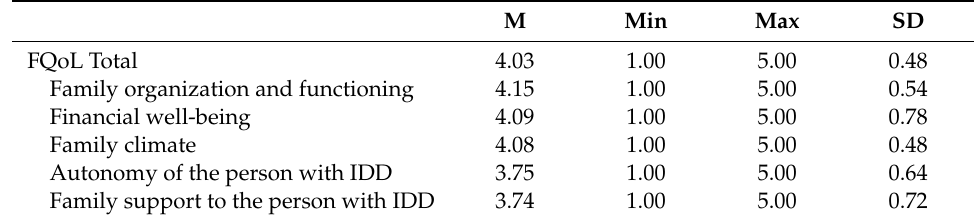
Table 6. Descriptive statistics of the total and each family quality of life dimension for the CdVF-ER > 18. M Min Max SD FQoL Total